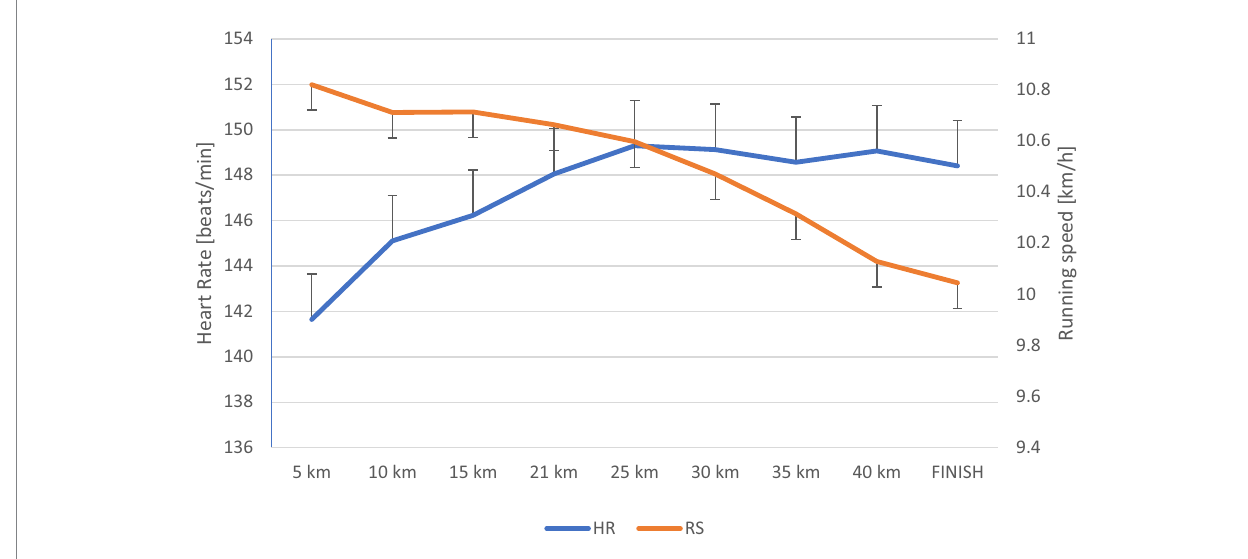
FIGURE 2 Changes in heart rate [beats/min] and running speed [km/h] during the marathon (mean ± SD).